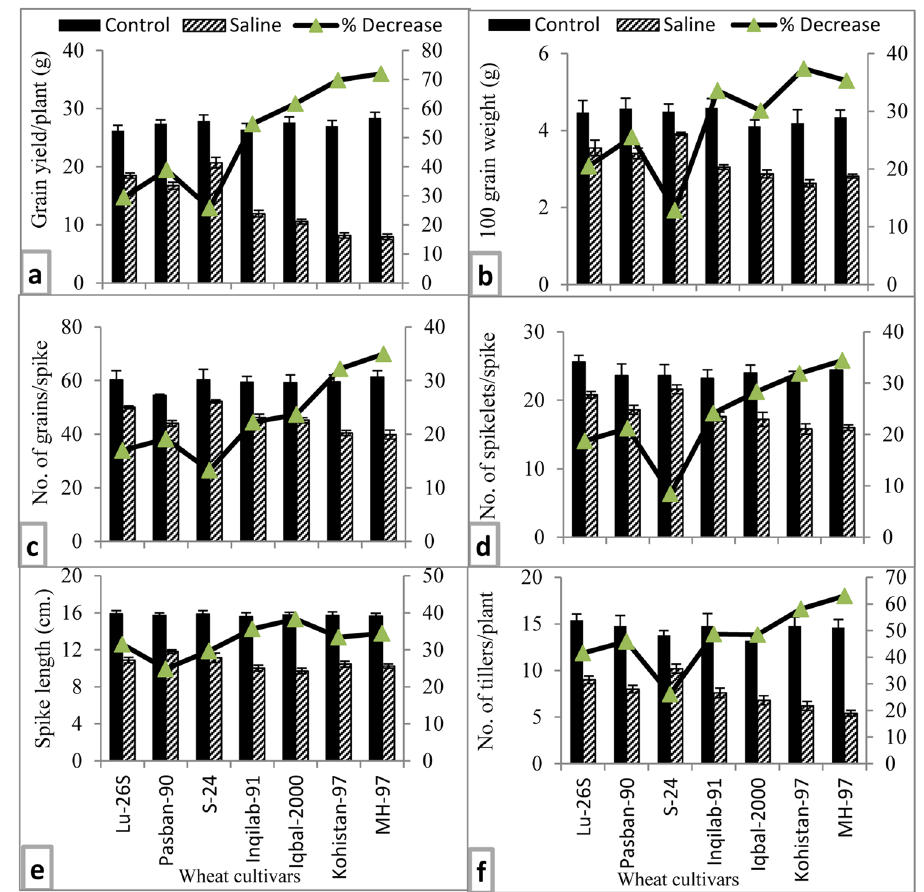
Figure 3. Yield parameters of selected salt tolerant and sensitive wheat cultivars at adult stage when plants of each cultivar were subjected to 0 or 150 mM NaCl salinity stress. Means are presented on primary vertical axis, while percent decrease value is presented on secondary vertical